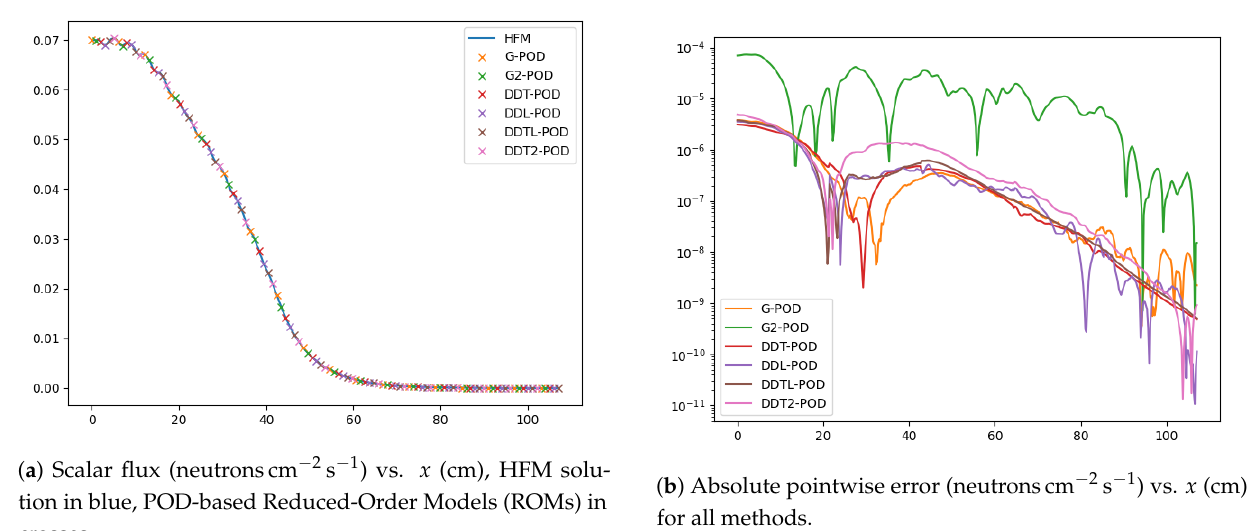
for all methods.